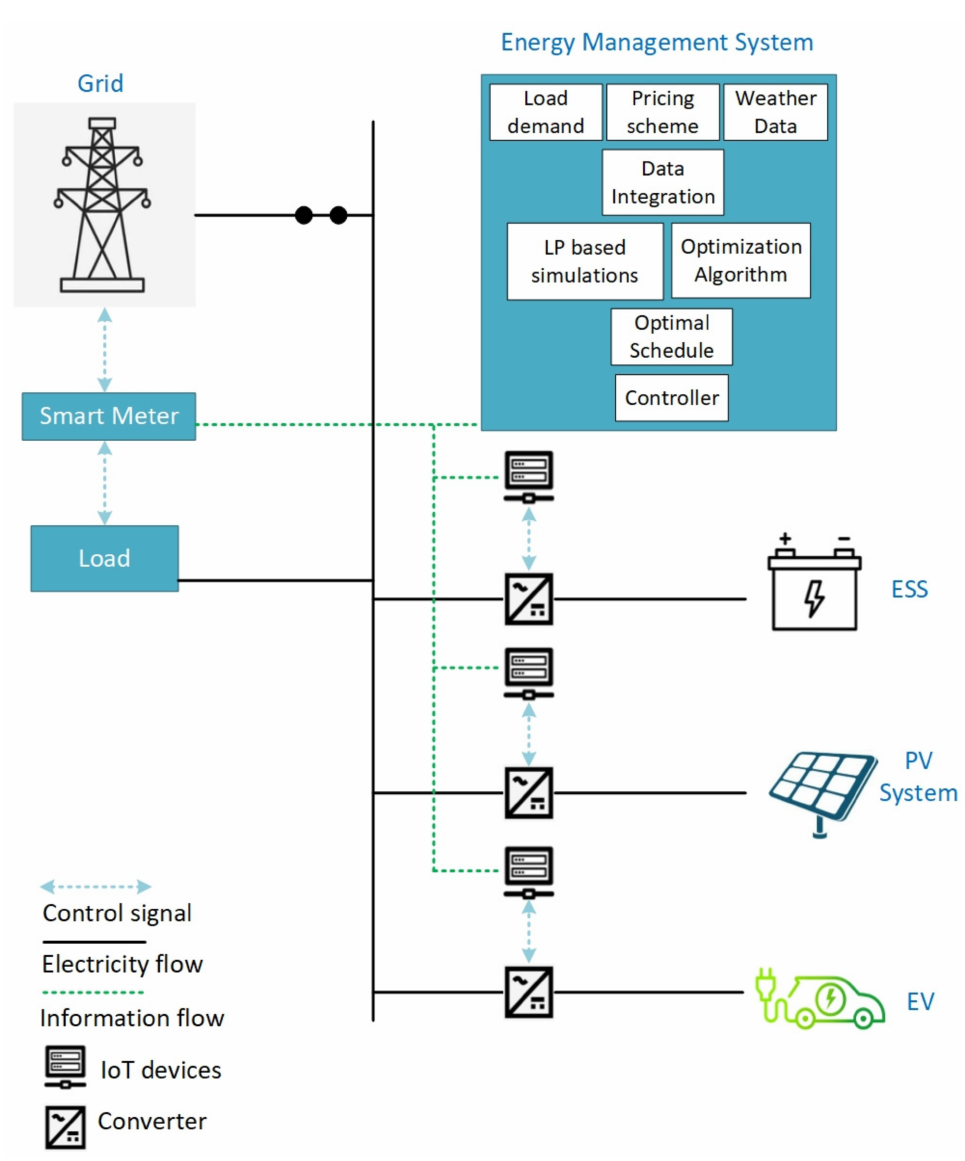
Figure 5. System